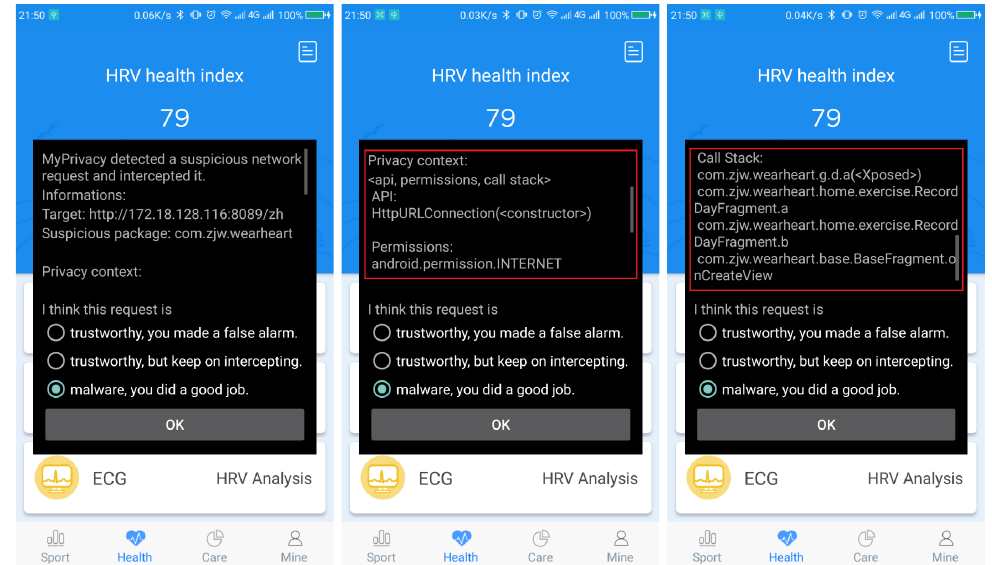
Figure 11. Interception to the malicious